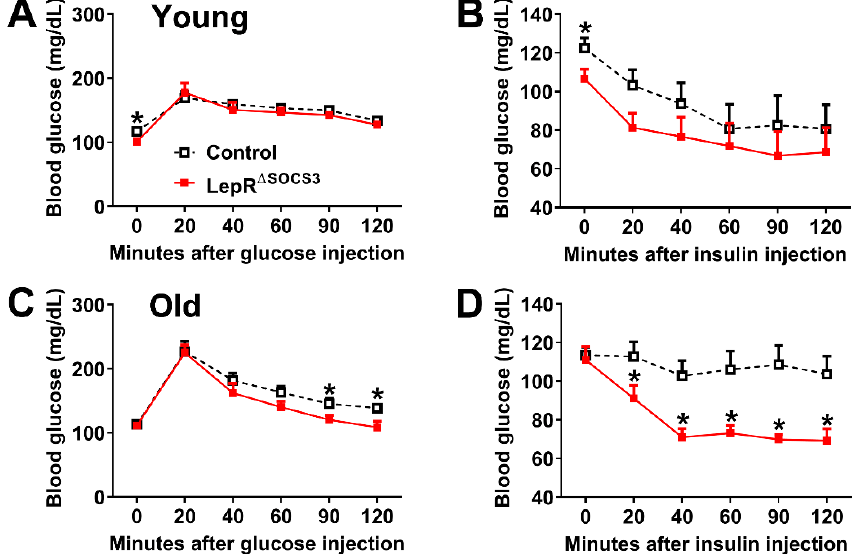
Figure 2. Improved glucose homeostasis in middle-aged LepR ∆ SOCS3 mice. ( A , B ) Changes in blood glucose concentrations during a glucose tolerance test and an insulin tolerance test in young adult (3-month-old) control ( n = 11) and LepR ∆ SOCS3 ( n = 10) mice. ( C , D ) Changes in blood glucose concentrations during a glucose tolerance test and an insulin tolerance test in middle-aged (15-month-old) control ( n = 21–26) and LepR ∆ SOCS3 ( n = 8–9) mice. Mean ± SEM. * p < 0.05 control vs. LepR ∆ SOCS3 (post-hoc test repeated measures two-way ANOVA).